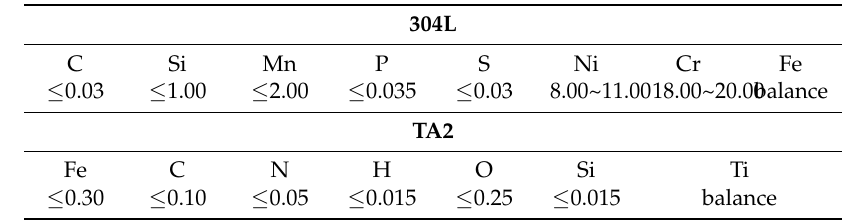
Table 1. Chemical compositions of 304L and TA2 (wt. %).